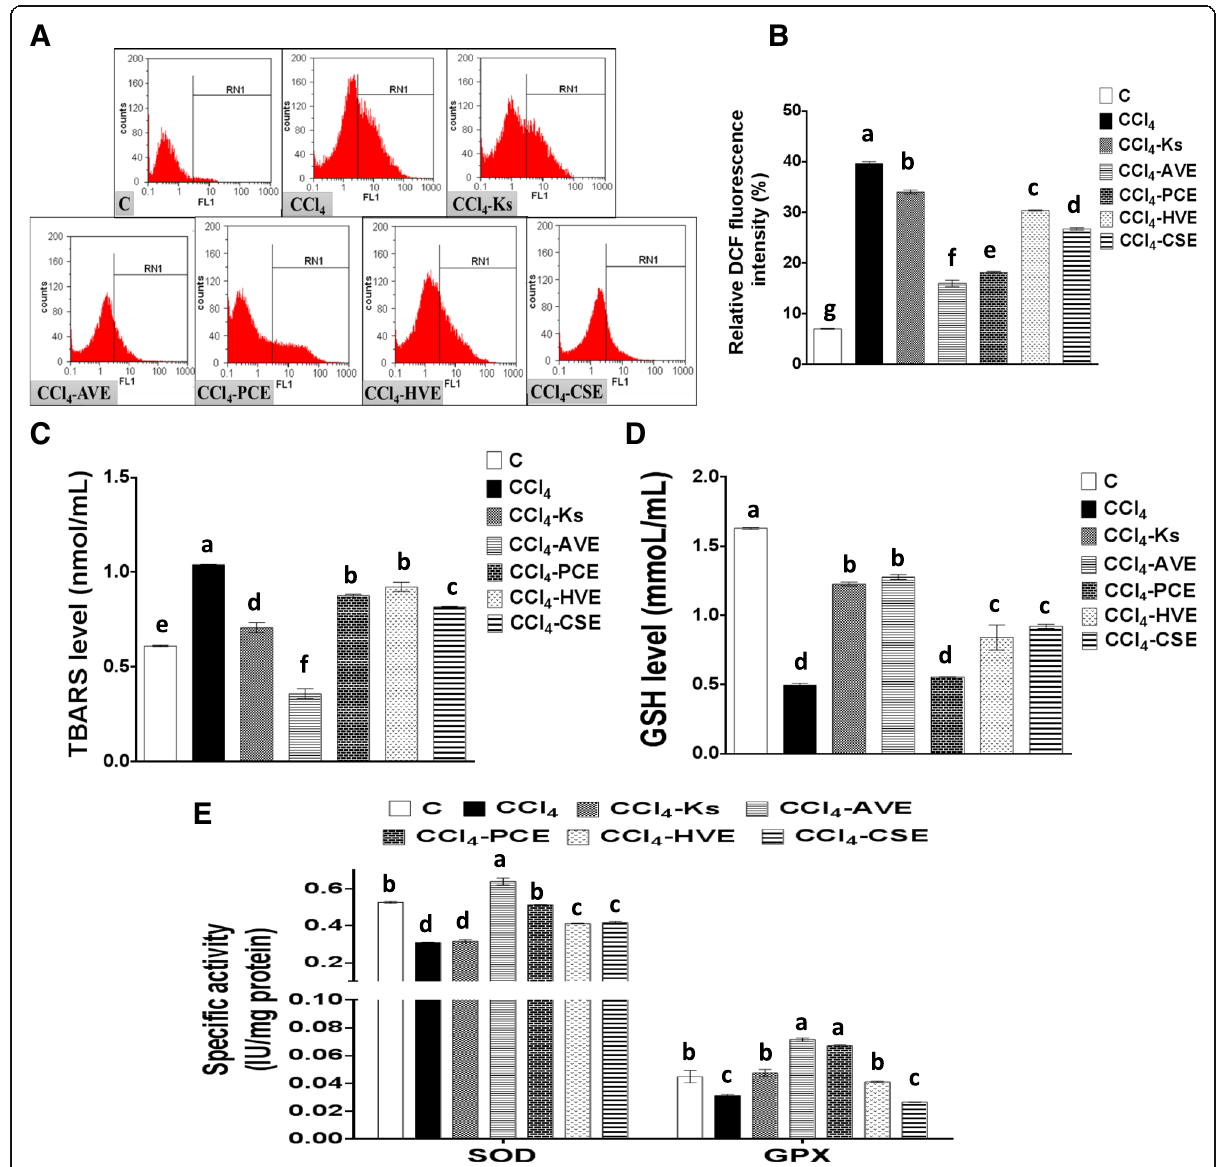
Fig. 3 Effect of the studied extracts on the carbon tetrachloride (CCl 4 )-induced oxidative stress in Vero Cells in comparison with the Ketosteril (Ks). ( a ) Flow cytometric analysis of ROS production in Vero cells using dichlorofluorescein (DCF) ( b ) Quantification of the DCF flow cytometric data ( c ) Thiobarbituric acid reactive substances (TBARS) level ( d ) Reduced glutathione (GSH) level ( e ) Superoxide dismutase (SOD) and glutathione peroxidase (GPX) activities. C ; the untreated control cells, AVE , Ammi visnaga extract; PCE , Petroselinum crispum extract; HVE , Hordeum vulgare extract; CSE , Cymbopogon schoenanthus extract. Results are presented as mean ± SE ( n = 3). Different letters for the same parameter are significantly different at p <